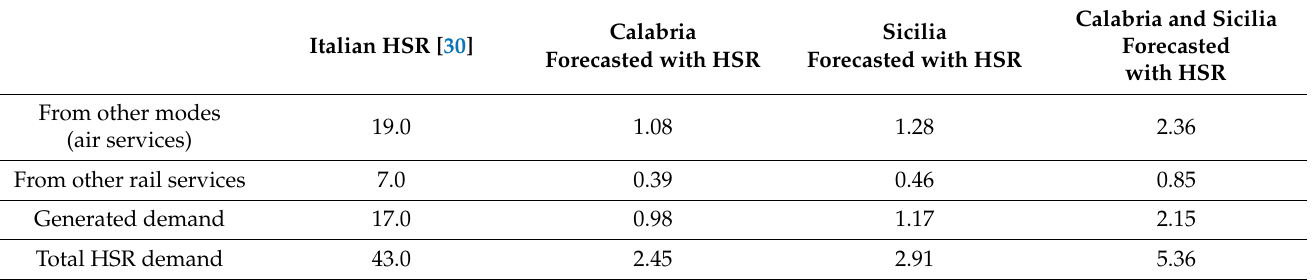
Table 3. Passengers/year from Calabria and East Sicilia to Rome and vice versa, in